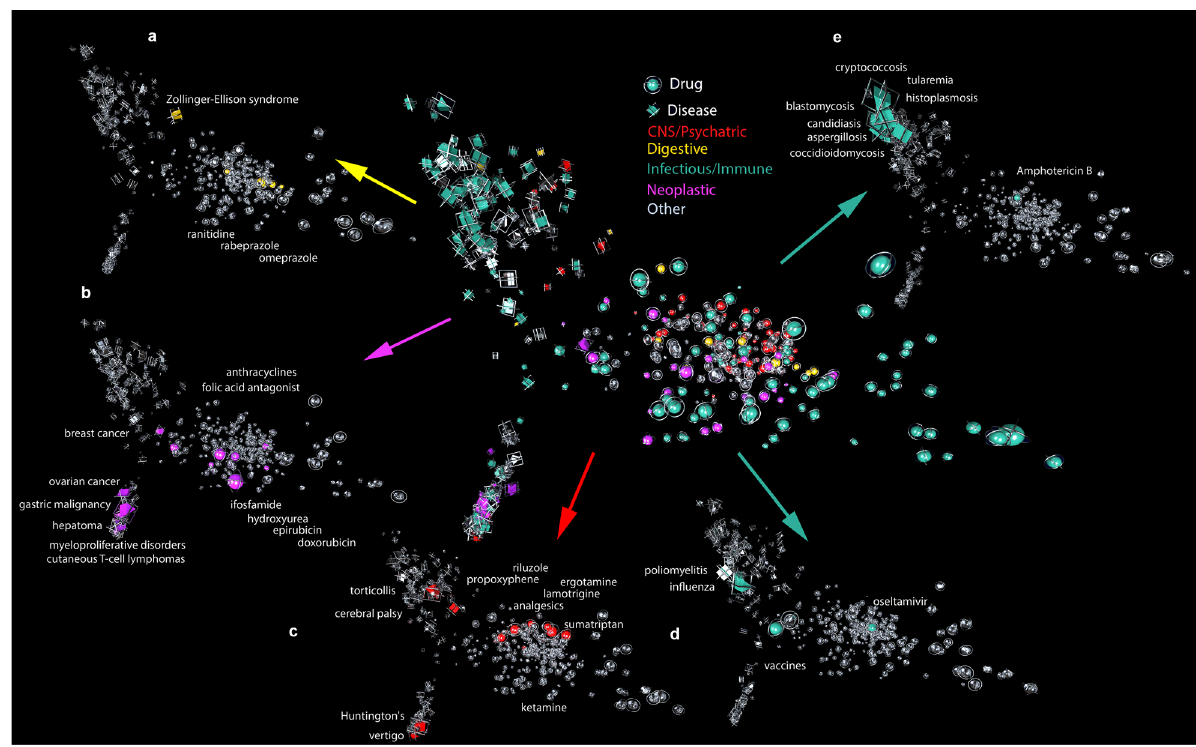
Fig. 3 Projection of text embedding into three-dimensional space. Properties of diseases and drugs are visible in the fi rst three principal components of our multi-dimensional text embedding. The fi gure shows a projection of text embedding into three-dimensional space, with named entities corresponding to diseases and drugs shown with prisms and spheres, respectively. The fi gure represents several projections of the same embedding, preserving spatial layout and projection, with distinct elements of the embedding indicated by shape color. The central image shows all disease systems and their corresponding medications together. More speci fi cally, the additional projections show: a Zollinger – Ellison syndrome and associated medications; b cancers and associated therapies; c central nervous system diseases and corresponding medications; d , e Viral and bacterial infectious diseases, respectively, together with corresponding antiviral and antibiotic agents, and f 3-dimensional projection of embedding drug- and disease-related named entities corresponding to CNS/Psychiatric- (red), digestive- (yellow), infectious/immune- (green), neoplastic- (cyan), and other diseases (grey). Another view of the same dataset is presented in Fig.